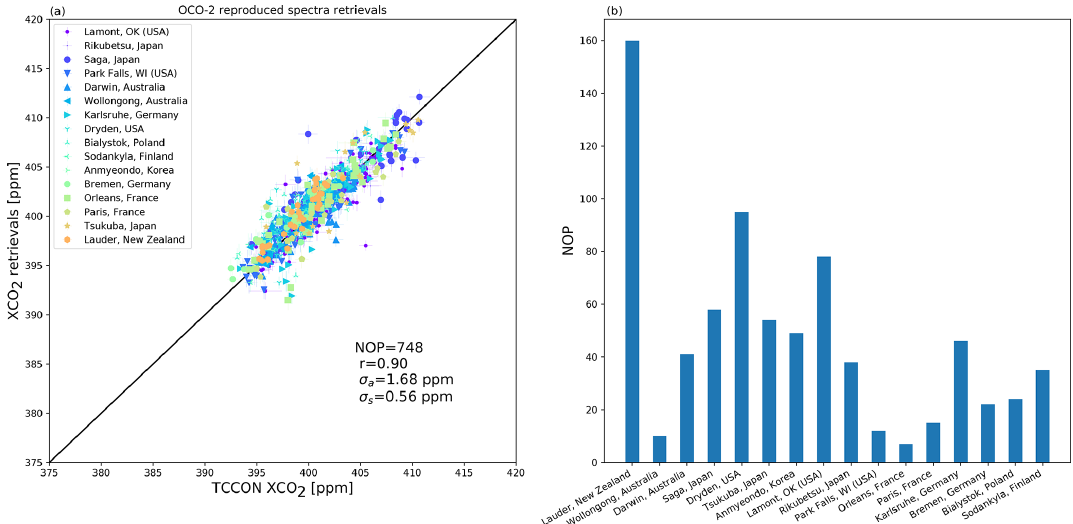
Figure 4. XCO 2 retrievals from MSR-d spectra reproduced from OCO-2 measurements. Panel (a) shows the overall validation and (b) shows the number of observations (NOBS) per station. In (a) we included the total number of observations ( n ), overall bias ( b ), single-sounding accuracy ( σ ), station-to-station variability ( σ s ), Pearson correlation coefficient ( r ), and one-to-one line. We subtracted a global bias of b = − 6 . 97ppm.